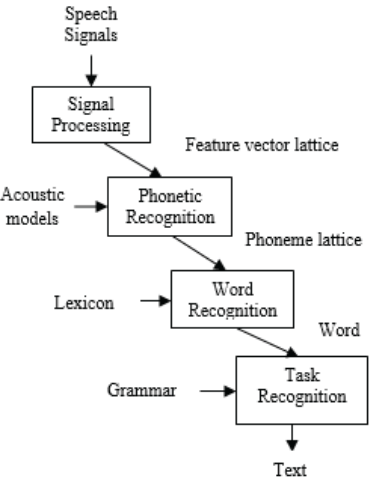
Figure 1: Speech Recognition in mechanism using HMM model